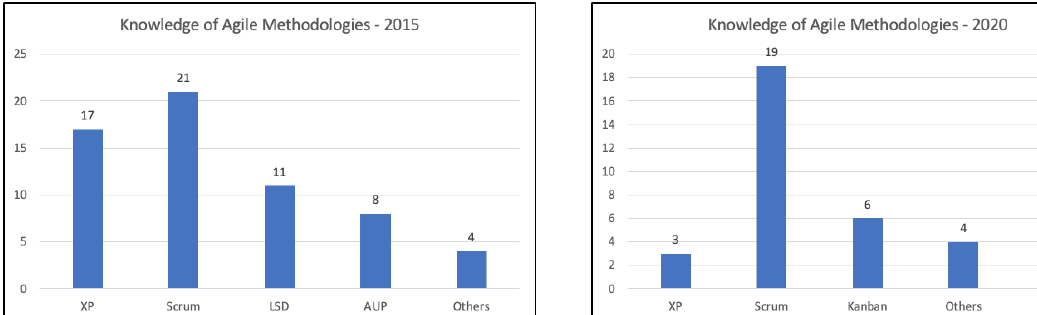
Figure 3. Knowledge of agile methods by respondents